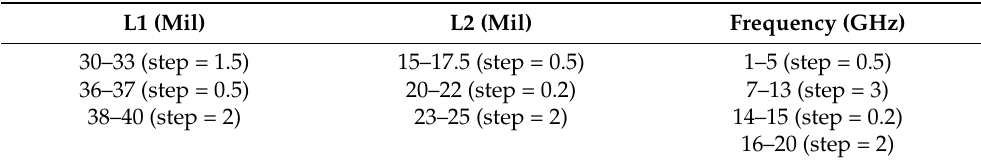
Table 5. Non-uniform sampling of rectangular